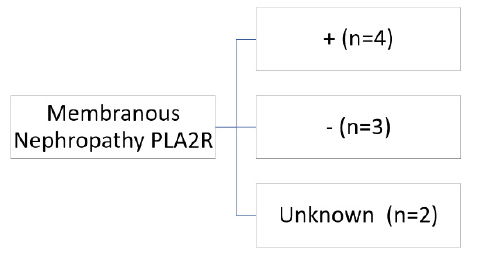
Figure 3. Antiphospholipase A2 antibodies in patients with membranous nephropathy. Table 6. Clinical features membranous nephropathy. Table 6. Clinical features membranous nephropathy.